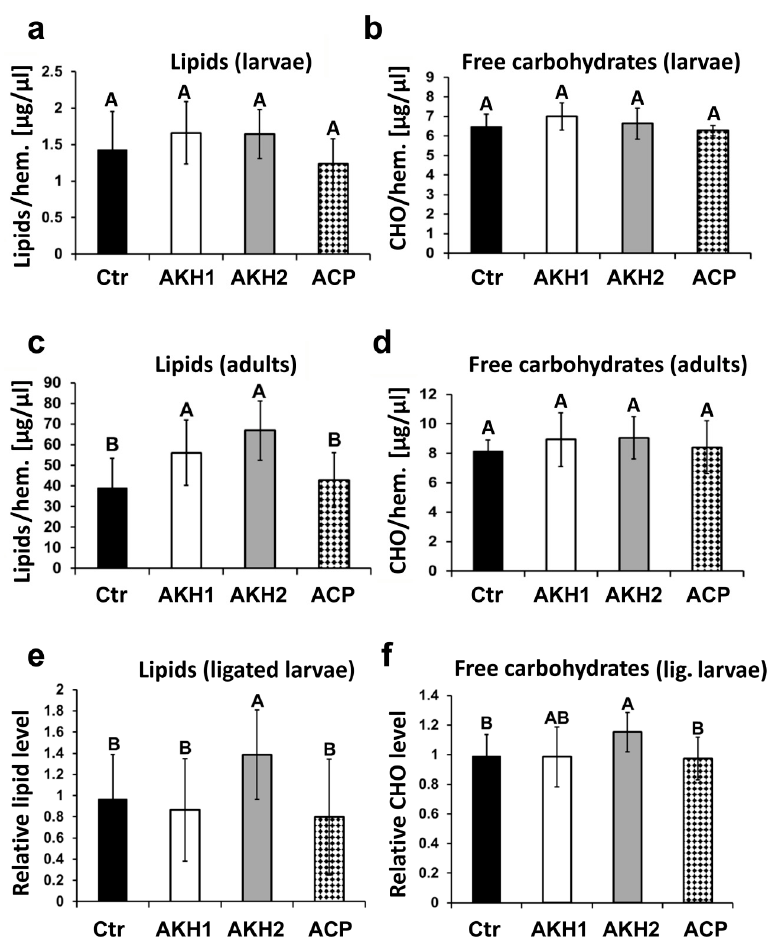
Figure 2. Effects of AKH peptides on the mobilization of carbohydrates and lipids. Fifth-instar larvae or adult moths were injected with 50 pmol of each peptide in 10% methanol/Ringer saline. Level of free lipids ( a ) and carbohydrates ( b ) in larval hemolymph; level of free lipids ( c ) and carbohydrates ( d ) in adult hemolymph; level of free lipids ( e ) and carbohydrates ( f ) in the hemolymph of ligated larvae. Ctr—saline-injected control group. Significant differences between groups on bar graphs are shown with different letters, p < 0.05, n = 16; ANOVA followed by Bonferroni’s post hoc test was used for statistical analysis. Error bars indicate standard deviation (SD).